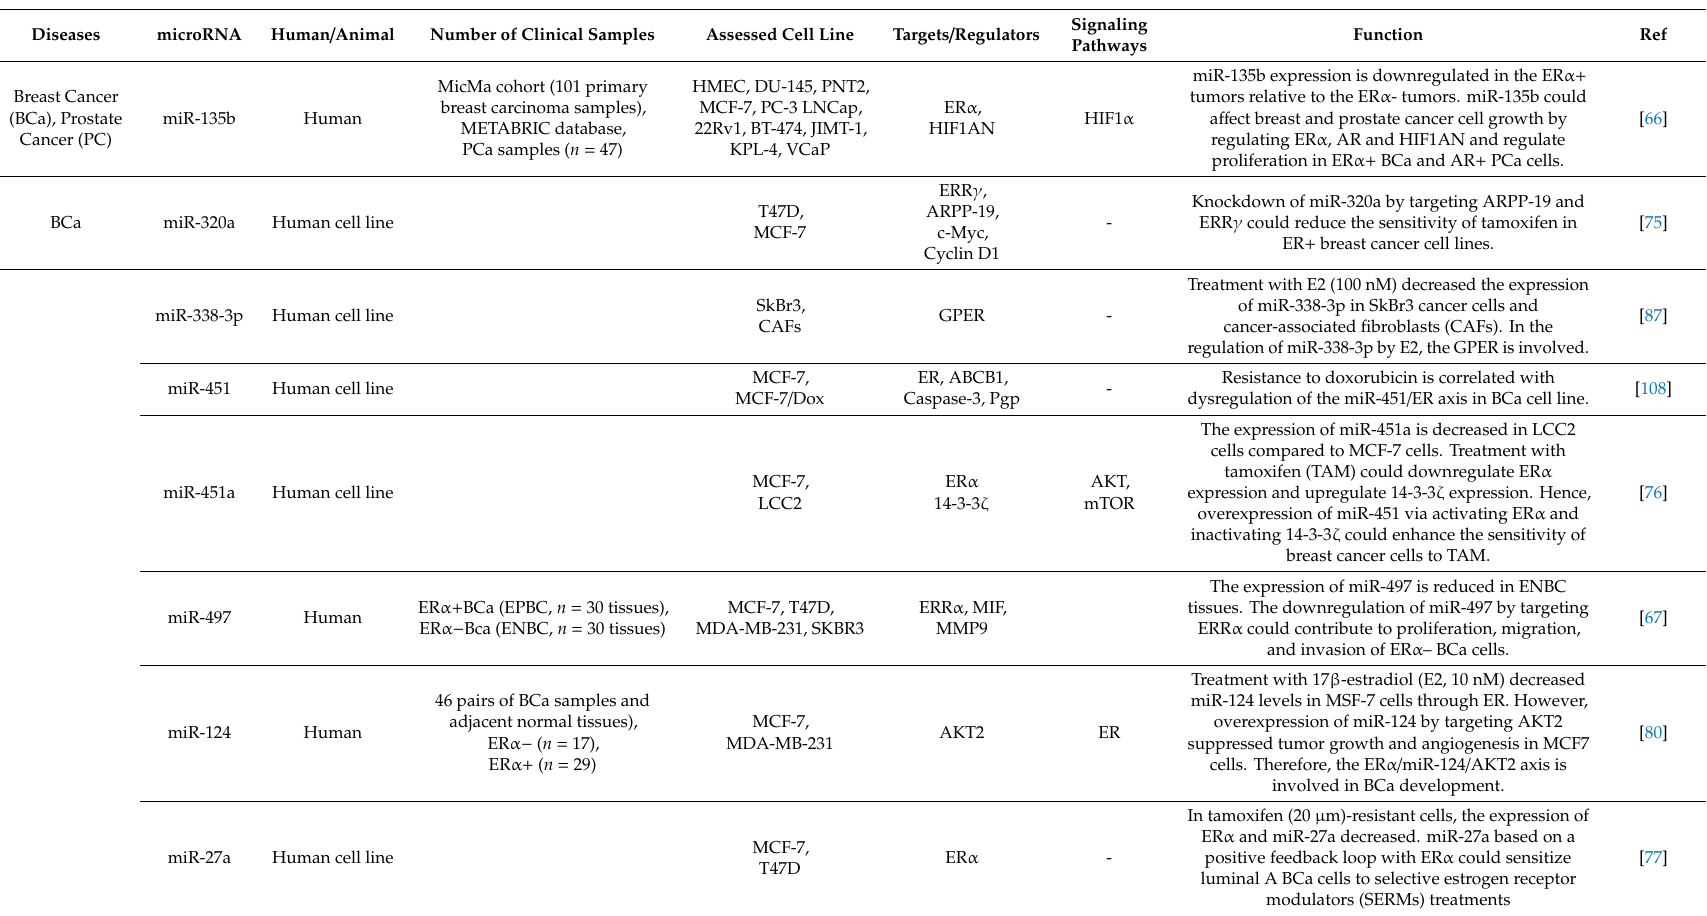
Table 3. List of downregulated ER-associated miRNAs in